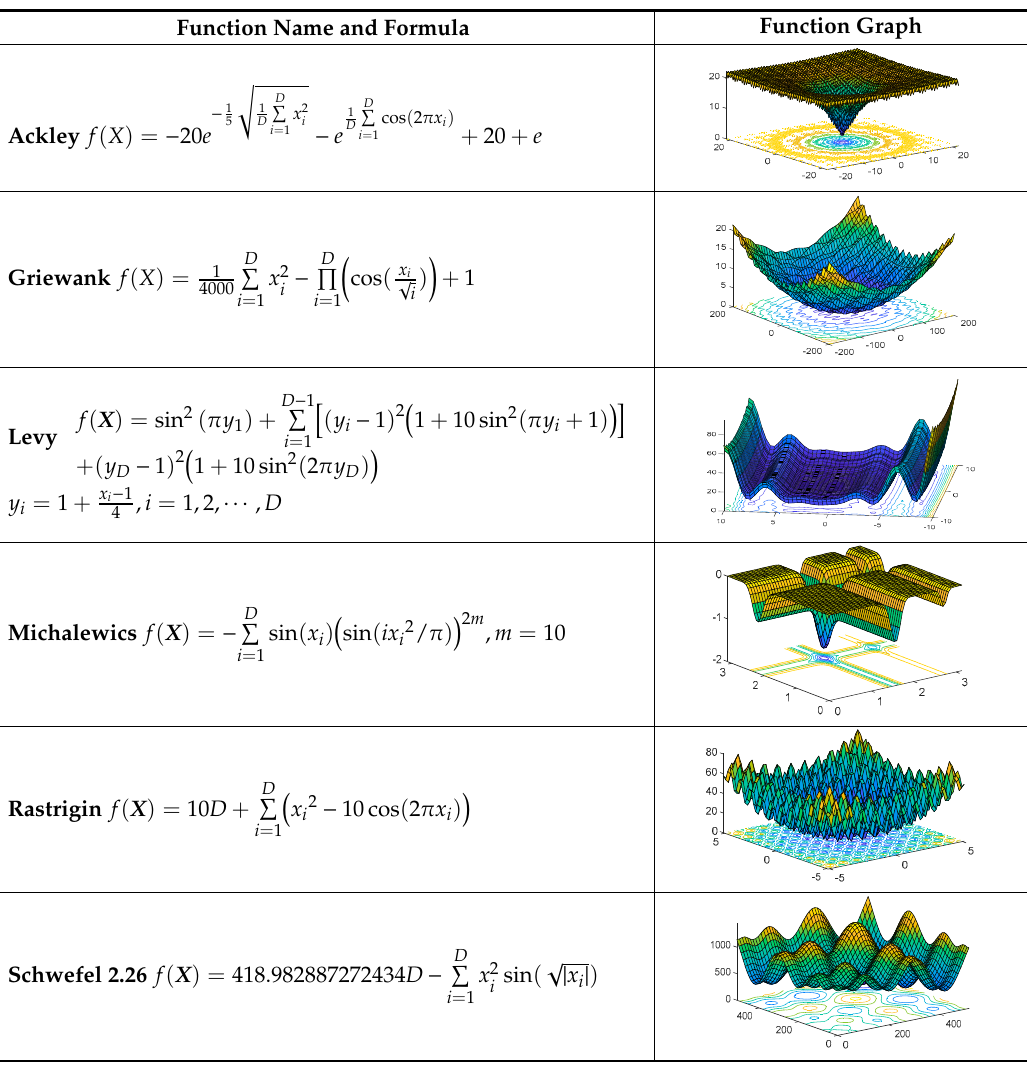
Table 1. Six classical benchmark functions.